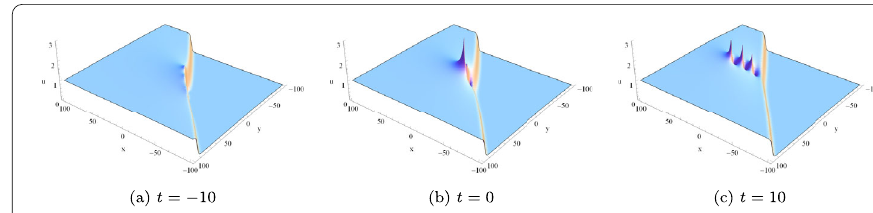
Figure 7 Plot of three lumps and a kink soliton fission with parameters p